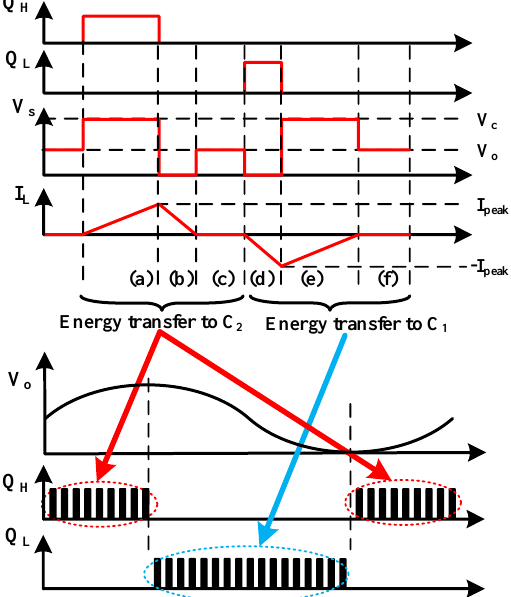
Figure 8. Inductor current, output voltage, and switching pulse waveforms during each half cycle.